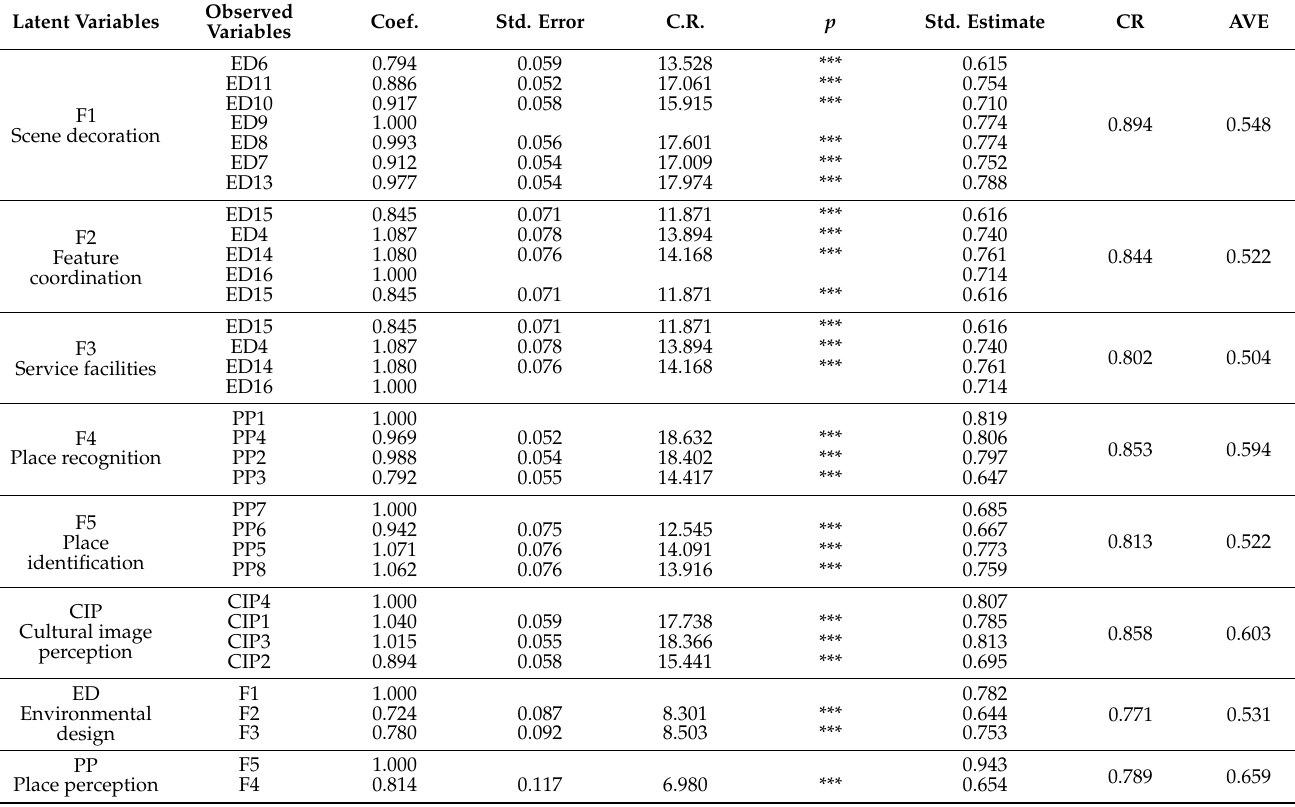
Table 9. Convergent validity result of